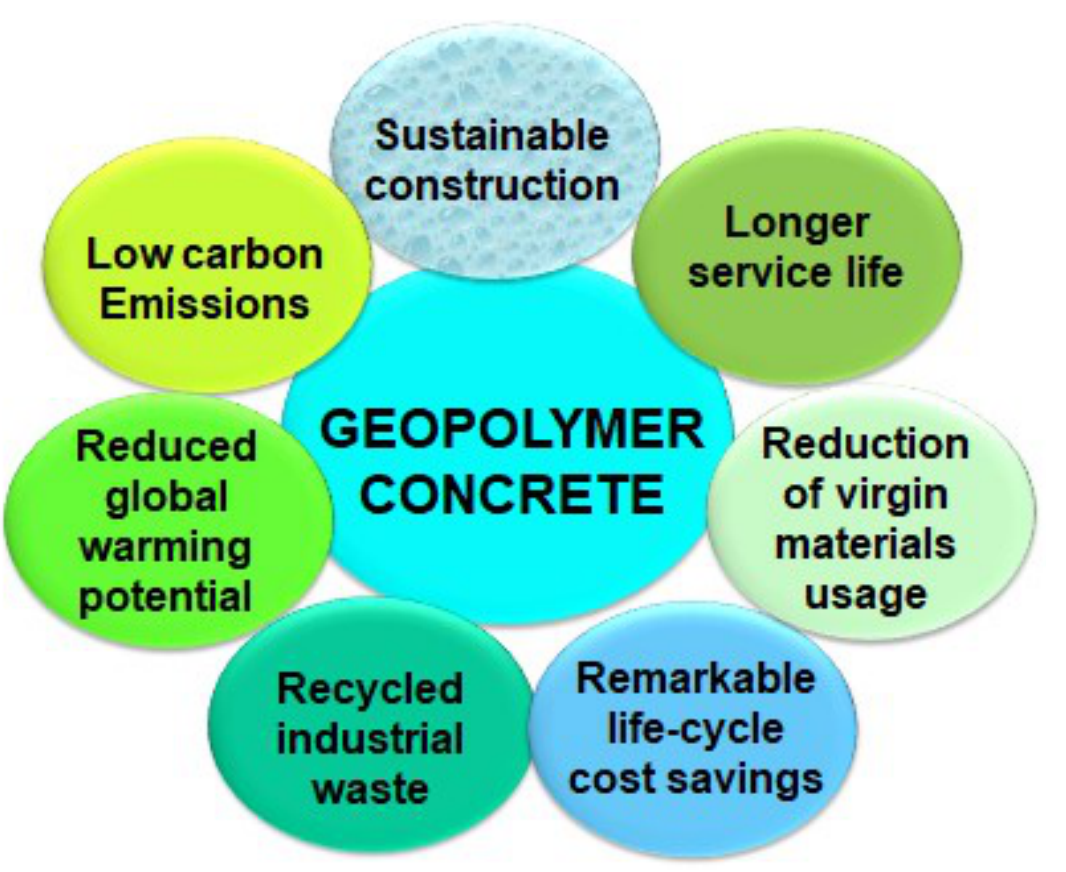
Figure 13. Advantages of geopolymer concrete in construction.